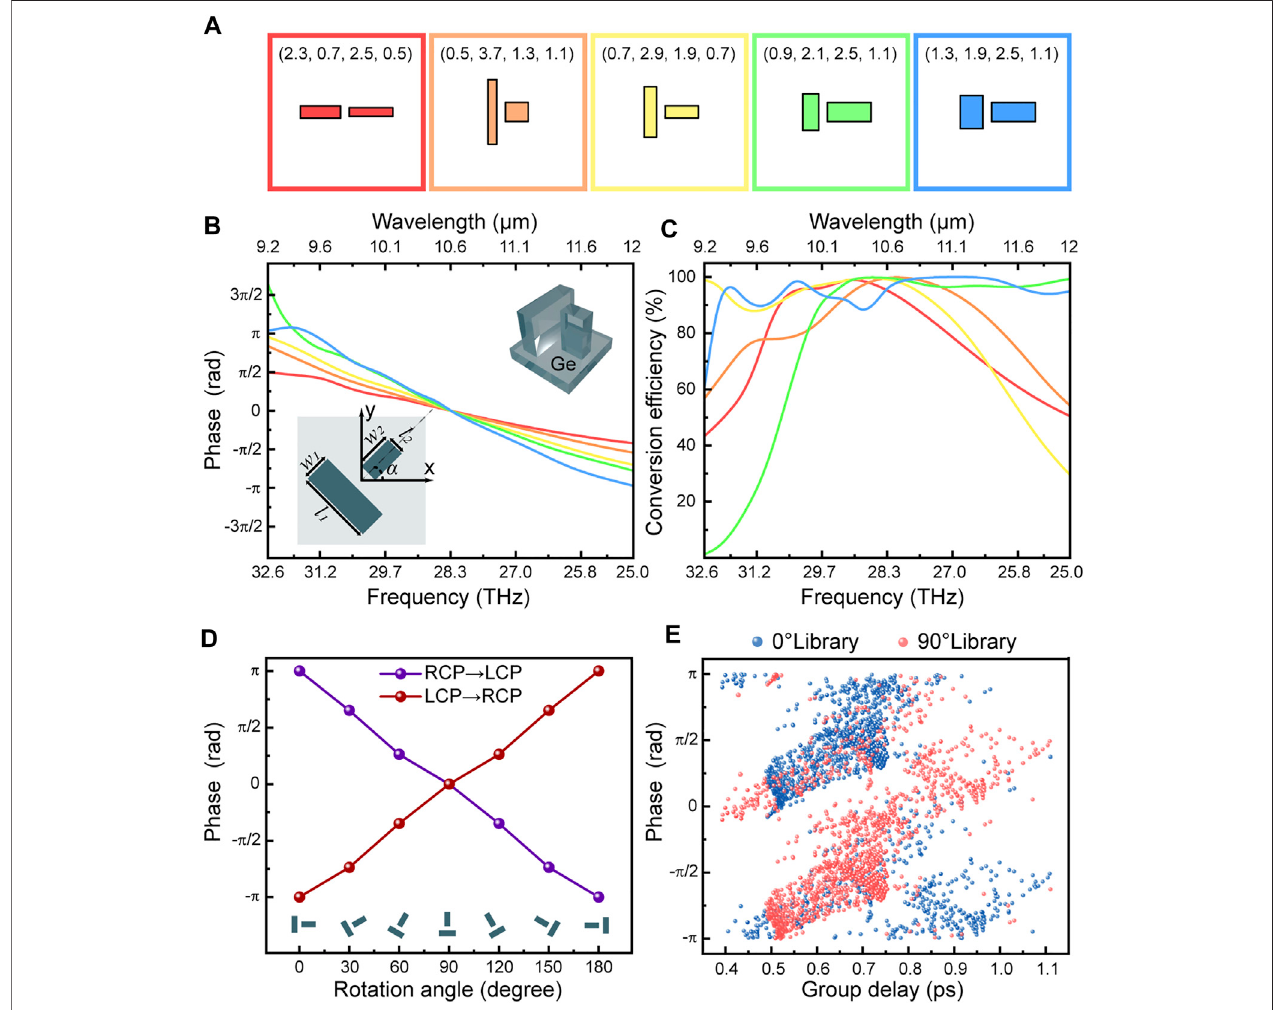
FIGURE 2 | Numerical results of the meta-atoms. (A) Schematic of the fi ve selected meta-atoms. (B,C) Phase and polarization conversion ef fi ciency of the fi ve selected meta-atoms. The fi ve meta-atoms with different geometrical dimensions satisfy the screening conditions mentioned in the text, i.e. linear phase versus frequency and high polarization conversion ef fi ciency within the designed bandwidth, but different group delays (the slope of phase with respect to the frequency). Each color curve corresponds to a meta-atom in the same colored box in (A) . The parameters in the colored boxes correspond to the geometric parameters (l1, w1, l2, w2)ofthenanopillarsshownintheinsetof (B) inmicrons,andthegapbetweennanopillarsisg=0.5 μ m. (D) Geometricphasewithrespecttorotationangleforthesame meta-atom under LCP and RCP incidence. The meta-atom has the same geometrical parameters as that in the yellow box in (A) . (E) The phase and group delay for all meta-atoms inthelibrary. Eachmeta-atom isrepresentedbyablueand red point intheplotbecause a90 ° rotationcanimpart aphasechangeof π withoutchangingthe group delay.